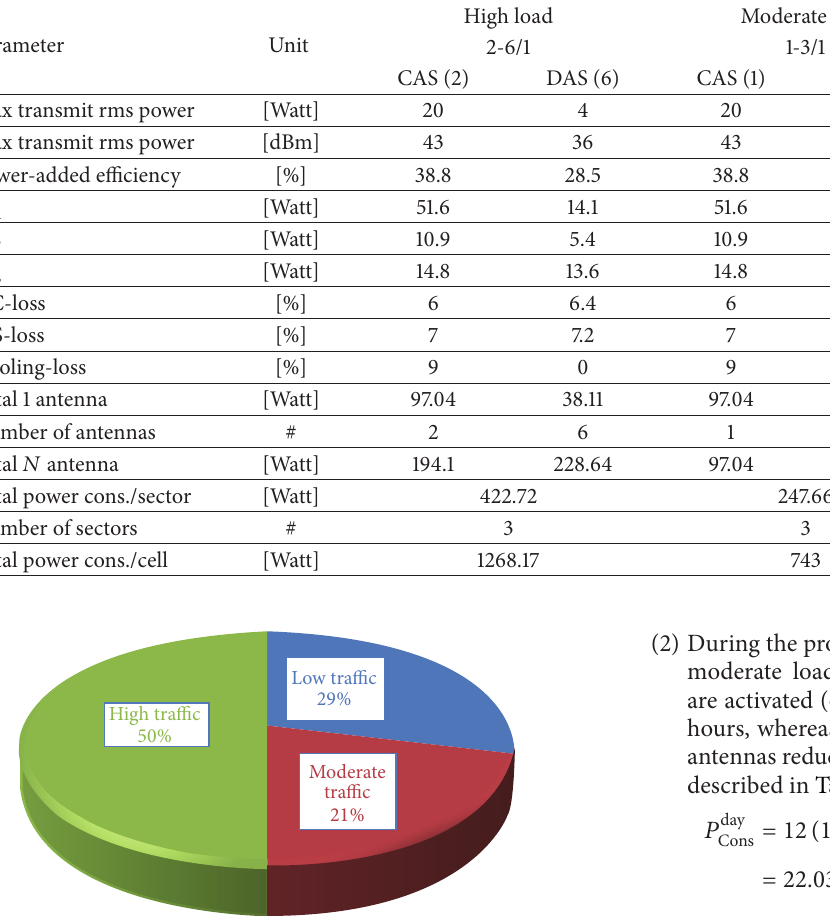
Figure 6: Percentage for each category of daily